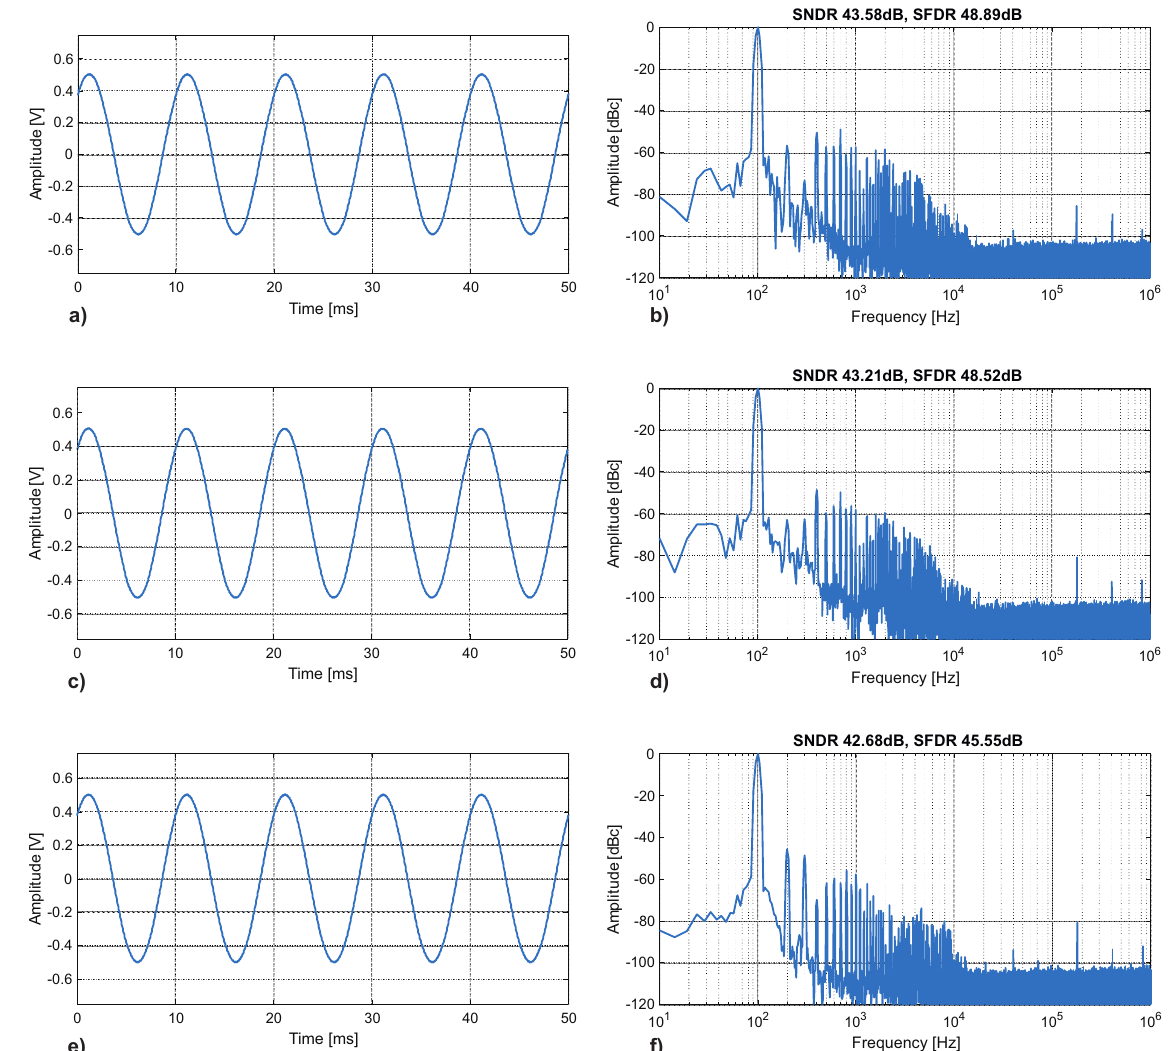
Figure 8. Time-domain waveforms and spectra of the low-frequency input signal and of the opamp output voltages with no EMI injection: ( a ) input signal, time domain waveform; ( b ) spectrum of the input signal; ( c ) MCP6V02 opamp output voltage, time domain waveform; ( d ) spectrum of the MCP6V02 opamp output voltage; ( e ) OPA2277 opamp output voltage, time domain waveform; ( f ) spectrum of the OPA2277 opamp output